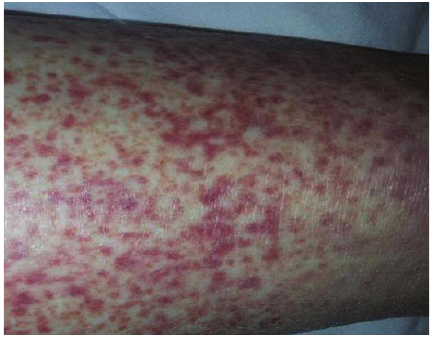
Figure 2: Cutaneous leukocytoclastic